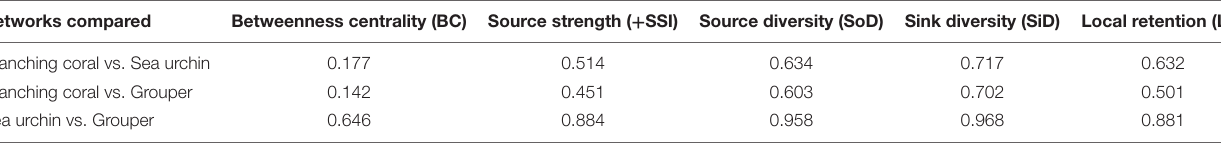
TABLE 2 | Pearson coefficient of determination ( r 2 ) between pairs of organism networks for each index. Networks compared